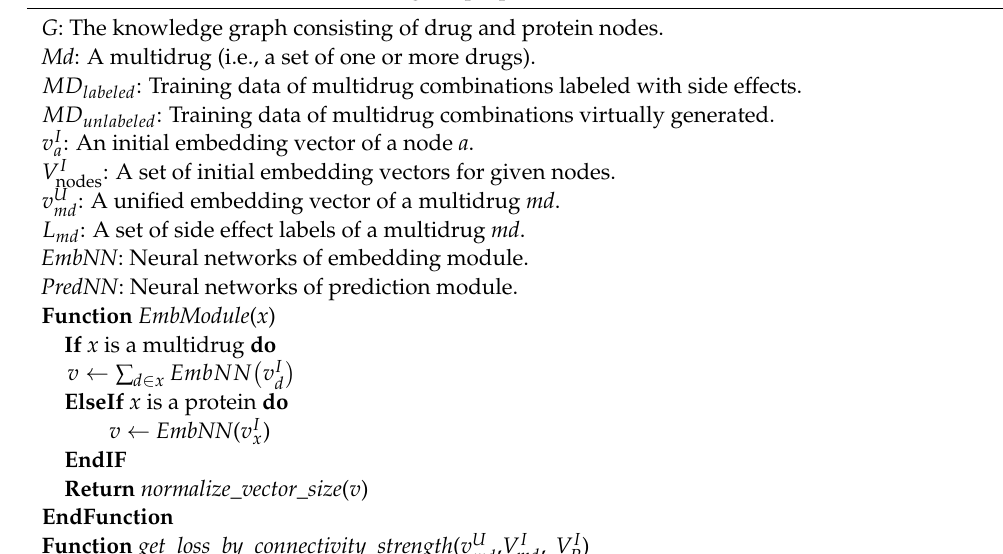
Algorithm 1. Pseudo code for training the proposed